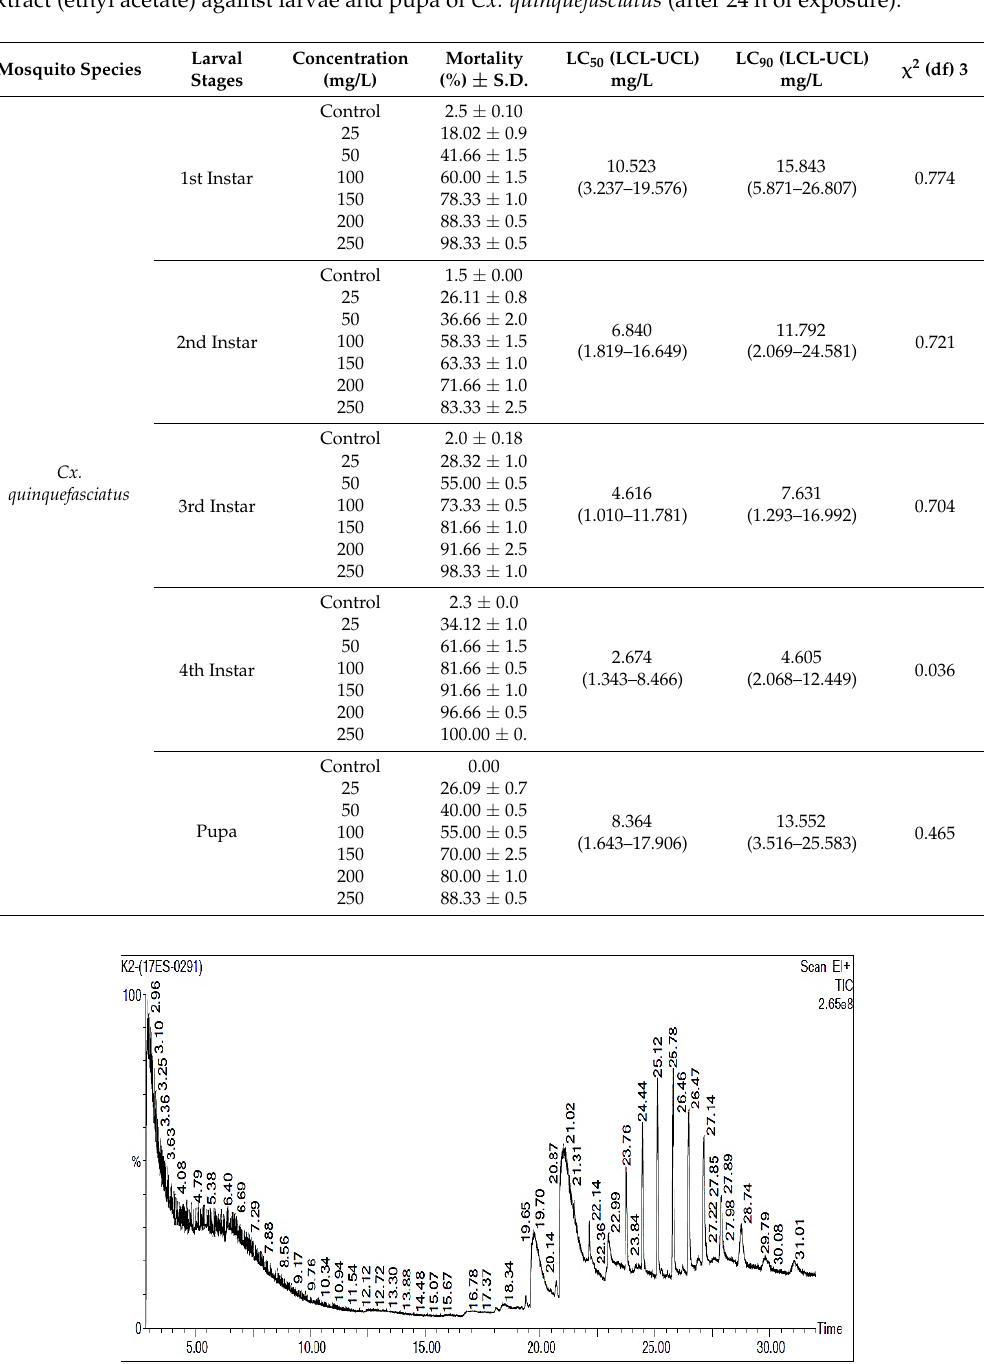
Figure 3. Compounds were identified from B.bassiana -28 extracts. Oven initial temp 60 °C for 2 min, ramp 10 °C min −1 to 300 °C, hold 6 min, Inject auto = 250 °C, volume = 1 μL, split = 10:1, carrier gas = He, solvent delay = 2.00 min, transfer temp = 240 °C, source temp = 240 °C, scan 50 to 600 Da, column 300 m~250 μm. Table 3 . Major bioactive compounds identified in the ethyl acetate mycelium extracts of B. bassiana -28 using Gas Chromatography-Mass Spectrometry analysis.